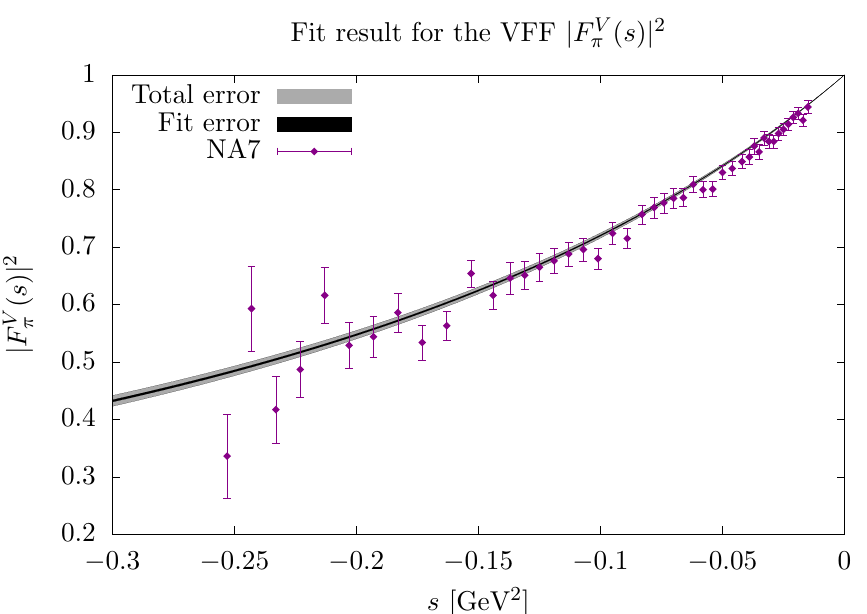
Figure 9. Fit result for the pion VFF in the space-like region, together with the NA7 data.